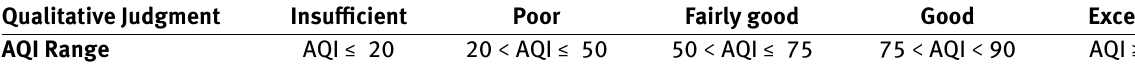
Table 2: Proposed AQI Range Classification